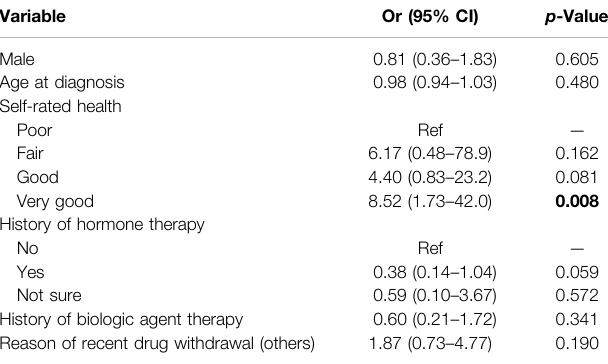
TABLE 7 | Multivariate logistic regression analysis of predictive factors for preference toward convenience of UST administration.